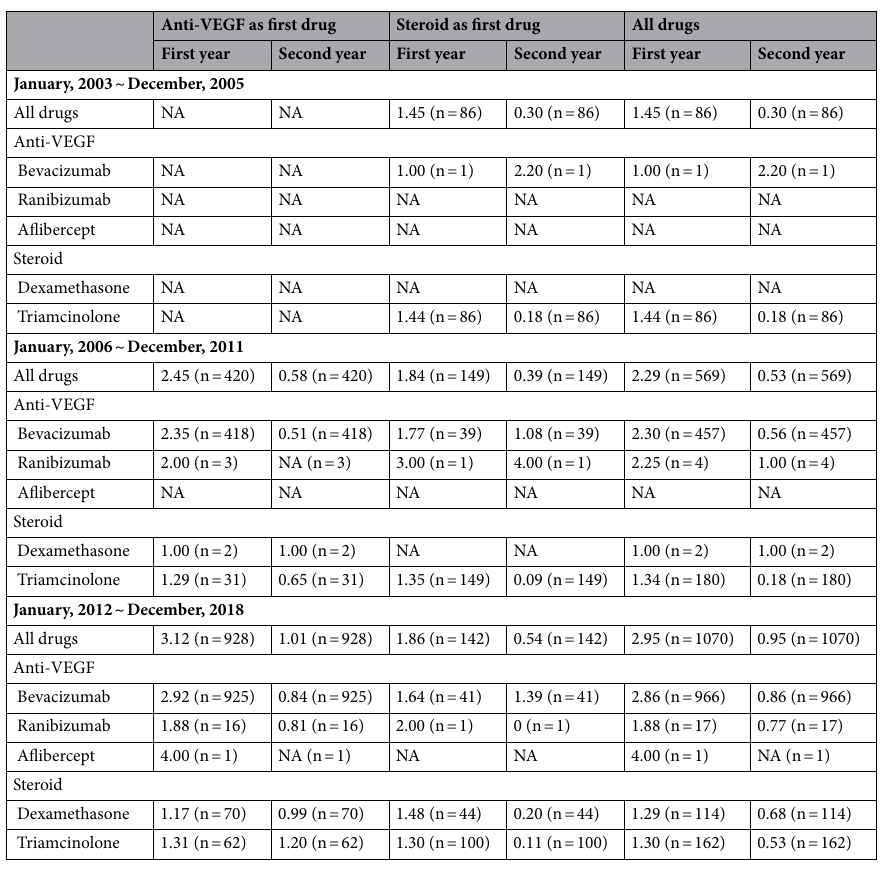
Table 2. Average number of intravitreal injections in patients observed for at least 2 years and treated with macular edema following retinal vein occlusion. VEGF, vascular endothelial growth